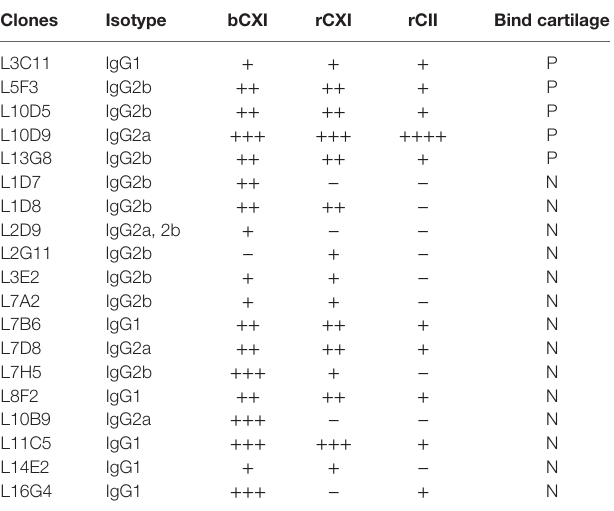
TaBle 2 | The characteristics of 19 monoclonal CXI antibodies. clones isotype